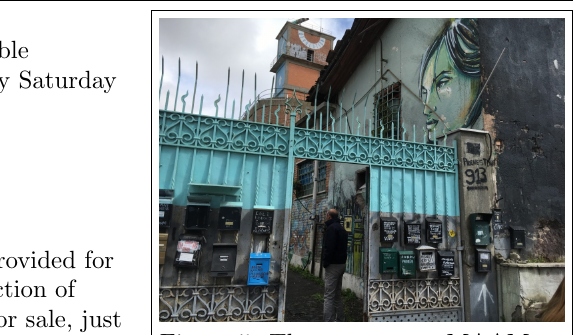
Figure 5: The gateway